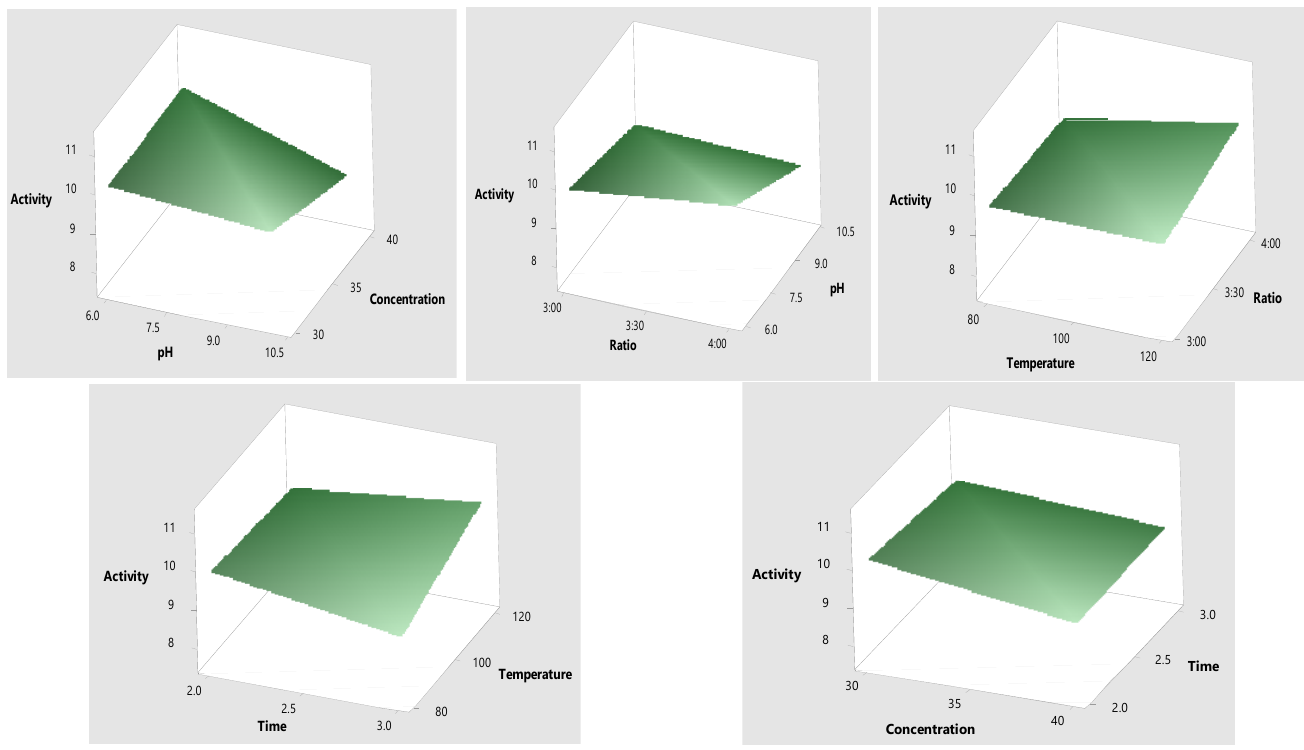
Figure 3. Three-dimensional surface plots of Mo-capped AgNPs. Table 4. Mo-capped AgNP synthesis optimization using Box–Behnken design.